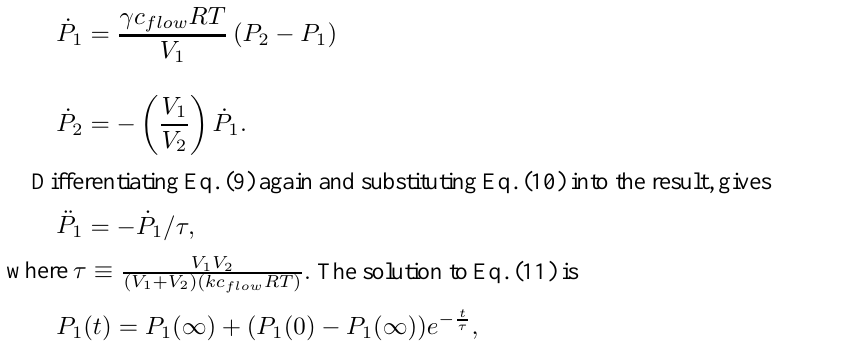
Fig. 4. The force reset event occurs in .040 seconds between the dotted vertical